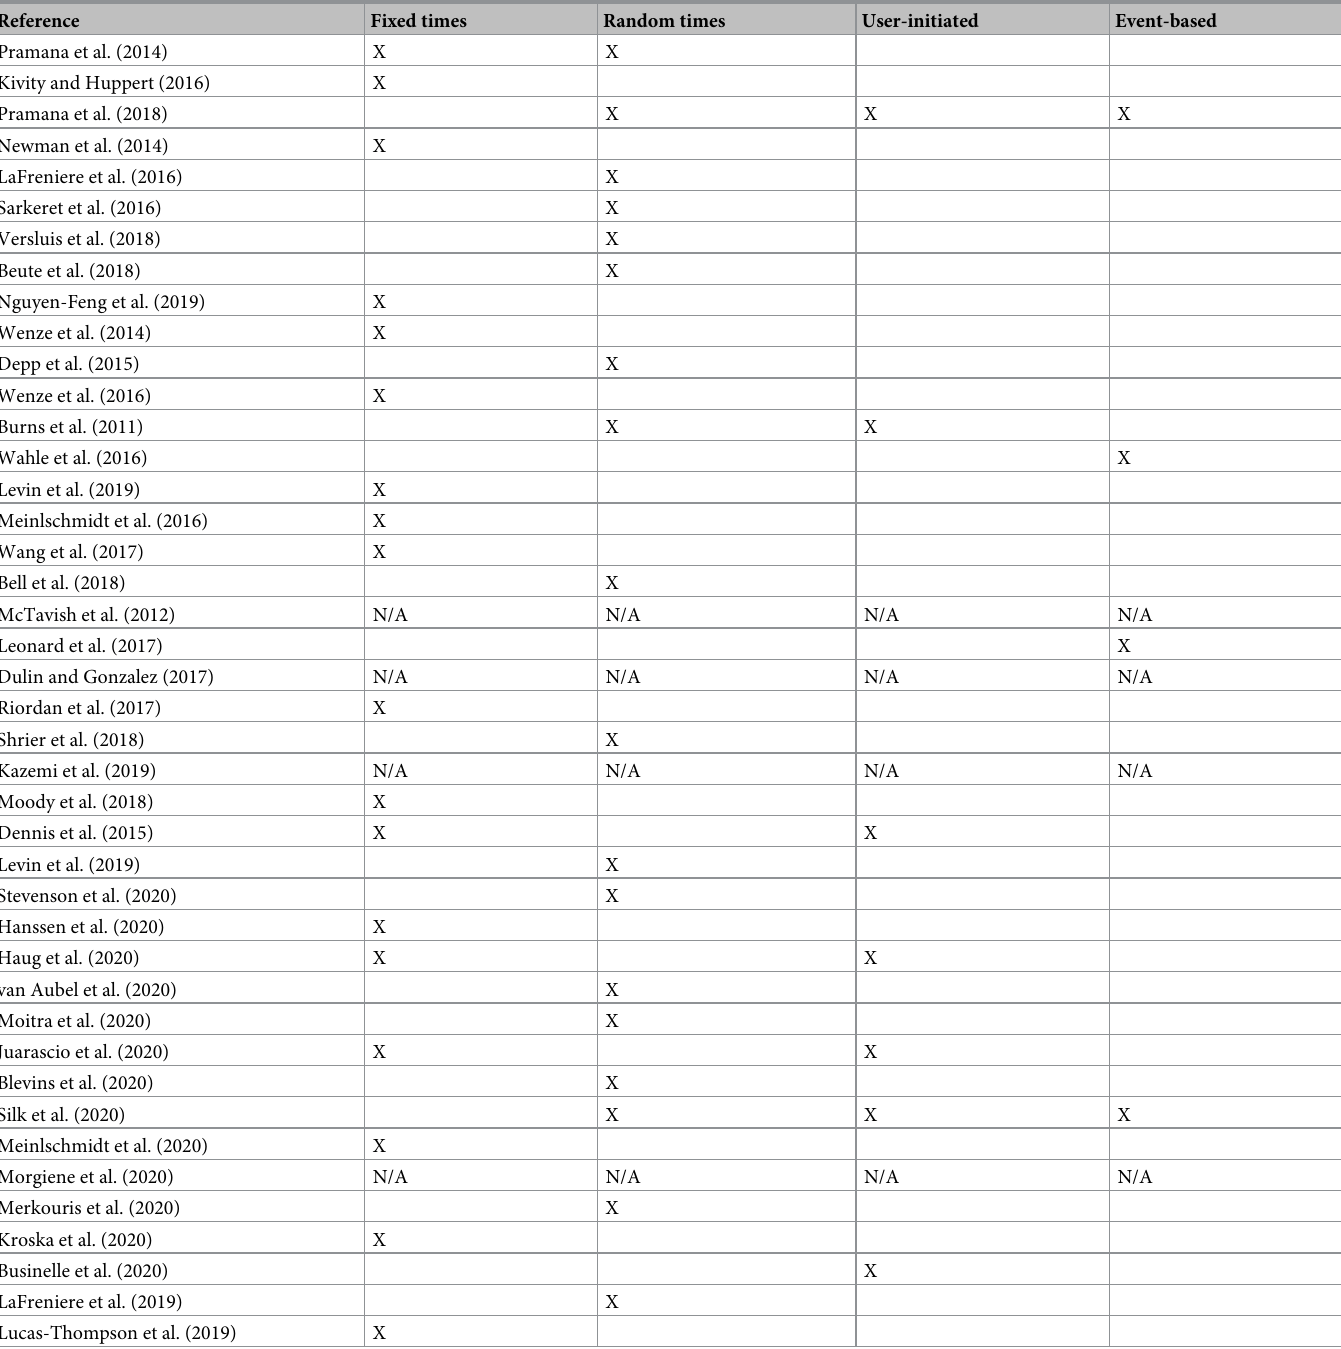
Table 2. Prompting of ecological momentary